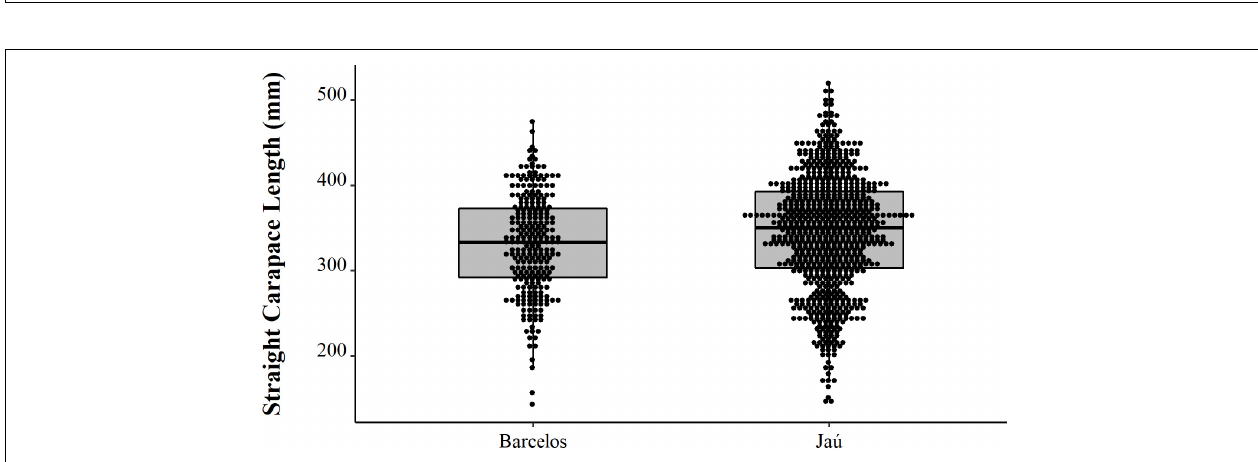
FIGURE 4 | Temporal distribution (points) and descriptive statistical (boxplot) of body size (SCL, mm) of Big-headed ( Peltocephalus dumerilianus ) from the PNJ collected in both sample periods (1997–2002 and 2019).